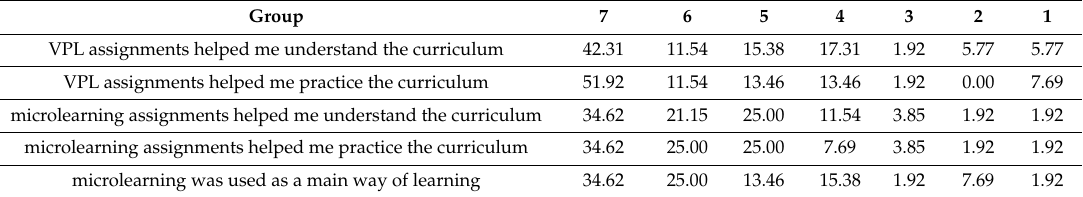
Table 15. Subjective perception of VPL and microlearning activities by